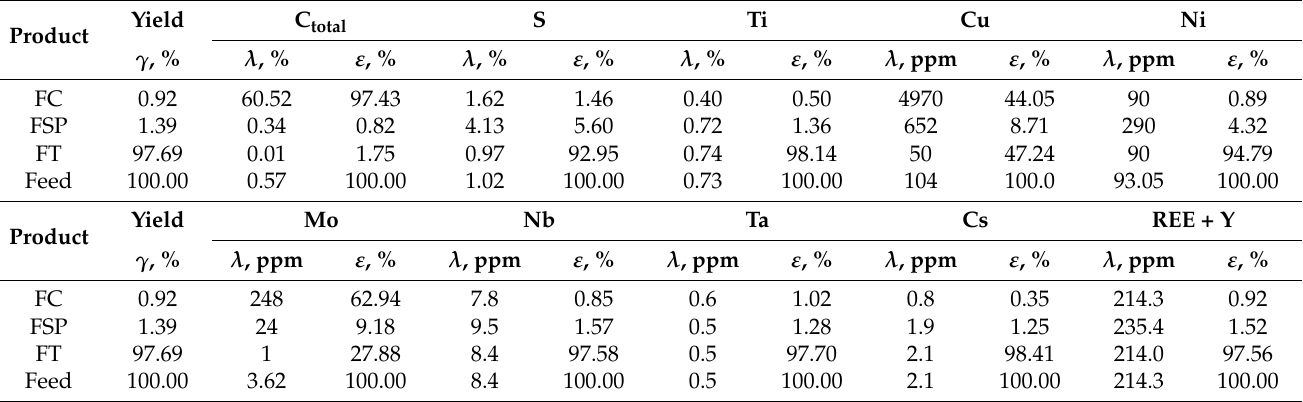
Table 4. The balance of collector-less flotation—analysis of the flotation of the selected chemical components.